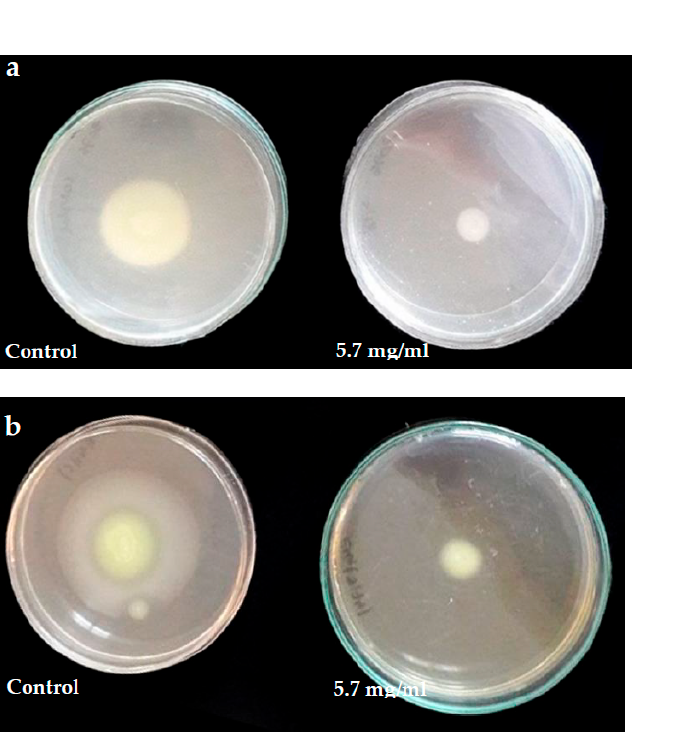
Figure 6. Inhibition of swimming after treatment with 5.7 mg/mL of TEO. ( a ) P. savastanoi pv. glycinea B076; and ( b ) P. syringae Q.